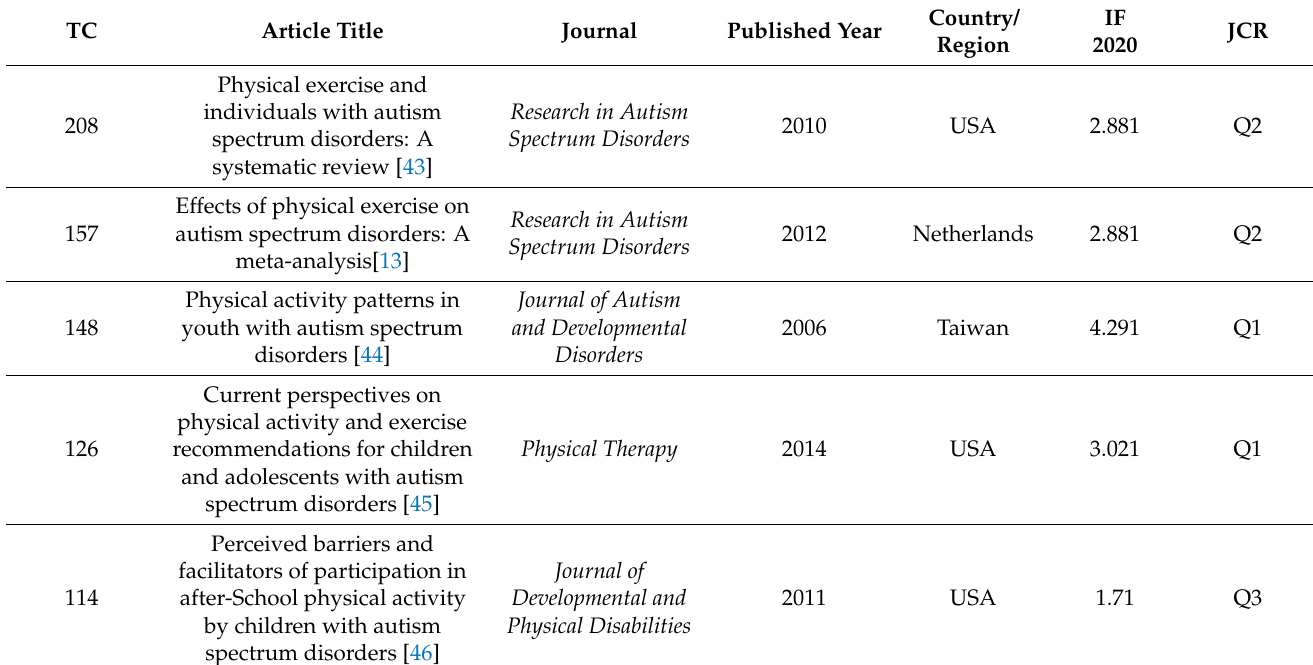
Table 3. The characteristics of highly cited documents on PA research of